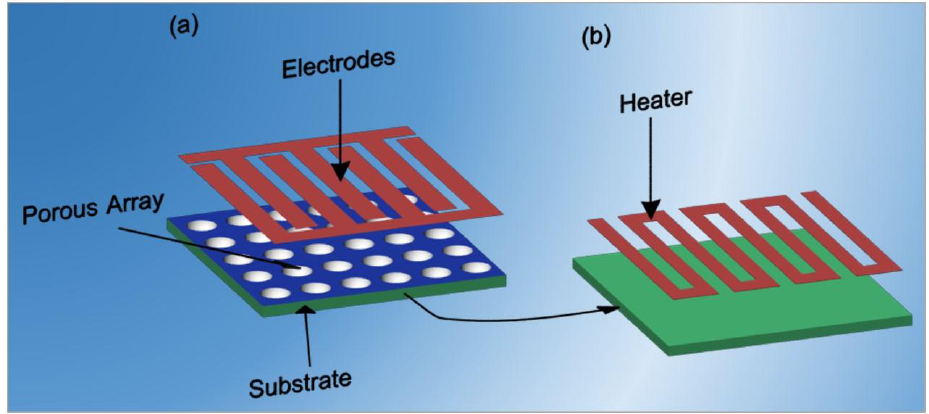
Figure 11. The design of a chemiresistive transducer. ( a ) The top-view of transducer: The porous structure and the interdigitated electrodes obtained on the porous array to read-out the signal. ( b ) The bottom-view of transducer with the heater deposited on the backside of substrate.